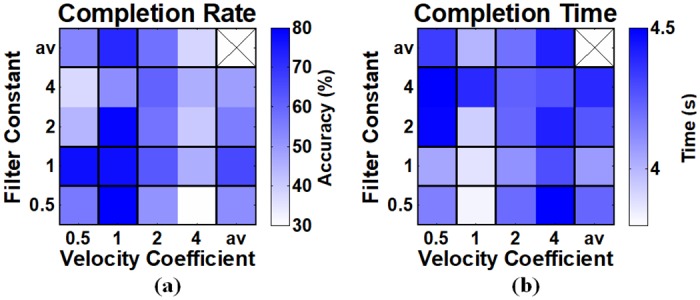
(a) Completion rate and (b) completion time calculated during the preliminary experiments.The label, ‘av’, denotes ‘average’, and the first row and last column show the average performance obtained using the corresponding parameter values. The best mean completion rate and time are obtained when 1/25 is used for the both parameters, considering the average performance of each parameter value. Also, the subjects who participated in the preliminary experiments mentioned more stable controllability with a combination of 1/25 filter constant and 1/25 velocity coefficient. Note that the values in x- and y-axis are normalized by the update rate (25 Hz).